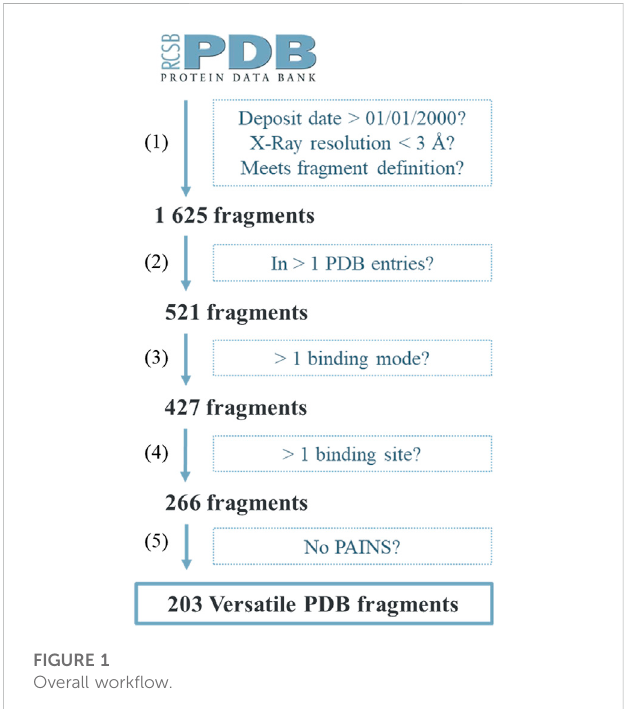
FIGURE 1 Overall work fl